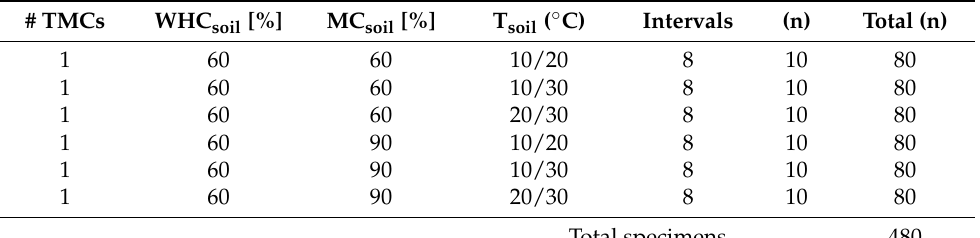
Table 3. Subset of wood decay data (ML wood ) with respective moisture and temperature (alternating) conditions, taken from Part 1 [34], used to test the goodness-of-fit of the developed dose–response model for wooden specimens exposed in soil contact. #